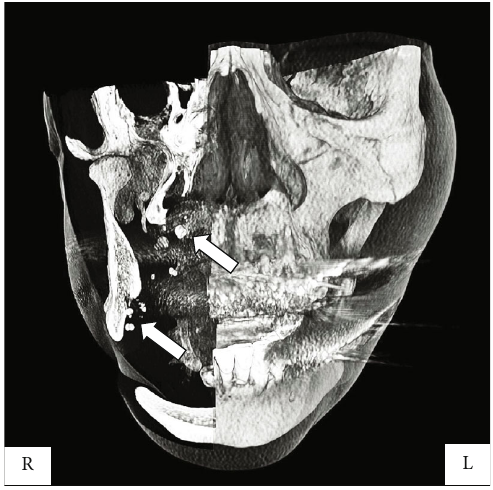
Figure 4: Computed tomography image showing numerous calci fi cations of unequal size in the medial portion of the right mandible. Circular hard tissue is evident